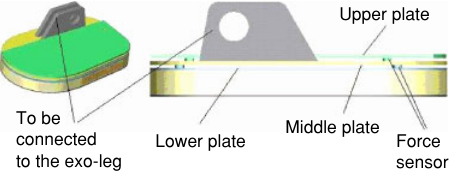
Figure 5 Design of the exoskeleton